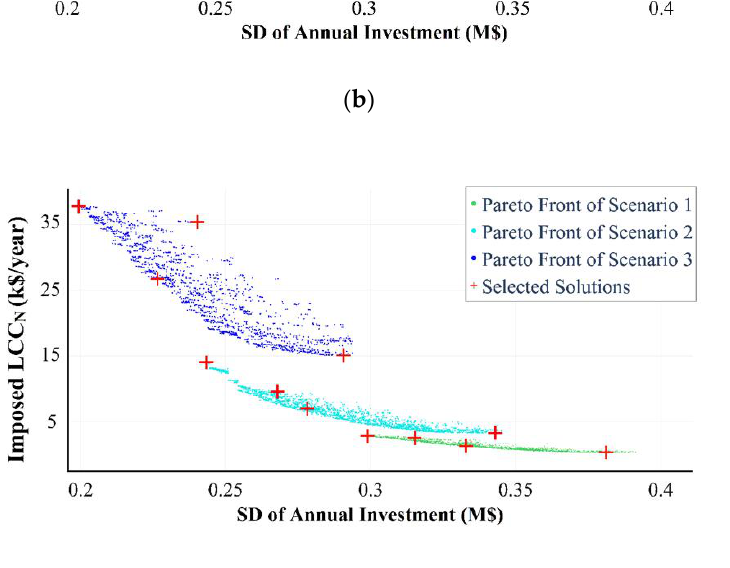
Figure 8. Two-dimensional projections of nondominated Pareto solutions for three scenarios: ( a ) comparison between average age and imposed LCC N , ( b ) comparison between average age and SD of annual investment, and ( c ) comparison between imposed LCC N and SD of annual investment .